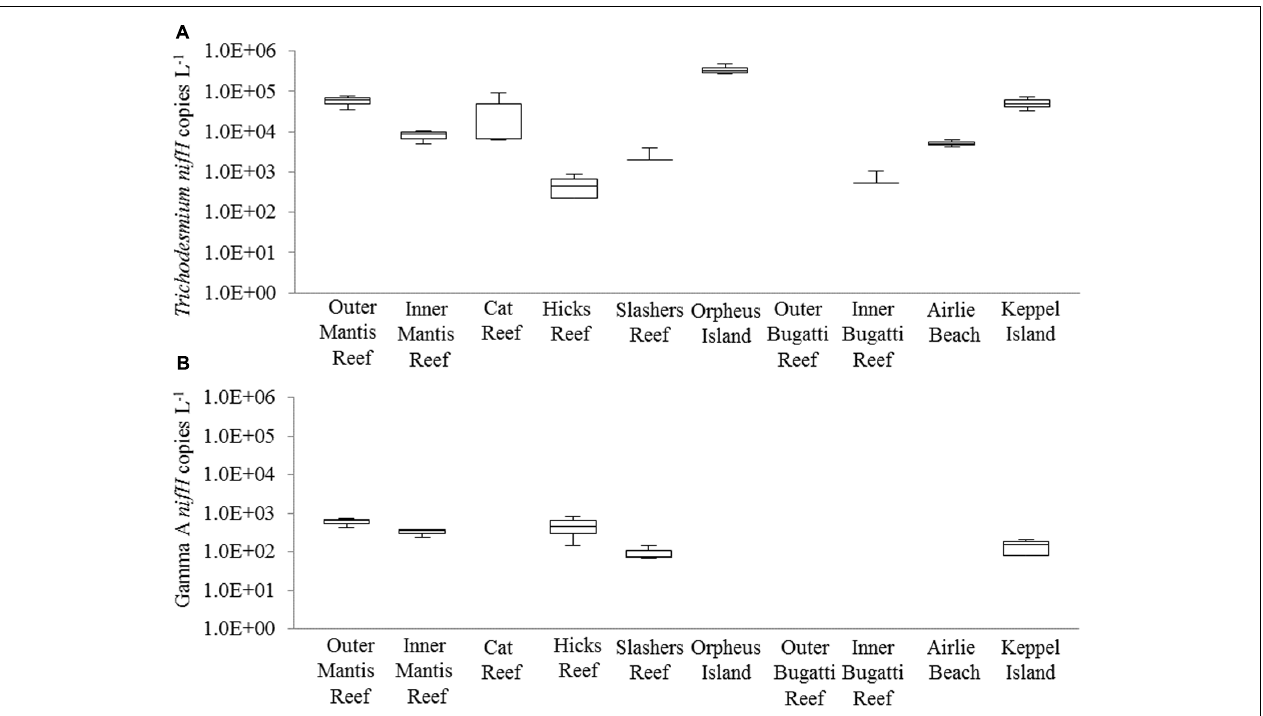
FIGURE 6 | Quantitative PCR (qPCR) abundances ( nifH copies L − 1 ) of (A) Trichodesmium and (B) the Gamma A clade across GBR sampling locations (from northern to southern waters). The box and whiskers represent the maximum value, 75th percentile, median value (50th percentile), 25th percentile, and the minimum value for the triplicate biological replicates. Where no box is present, genes were detected but were below the limit of quantification and were therefore given values of “0.” Please note the y-axis is shown on the log scale for